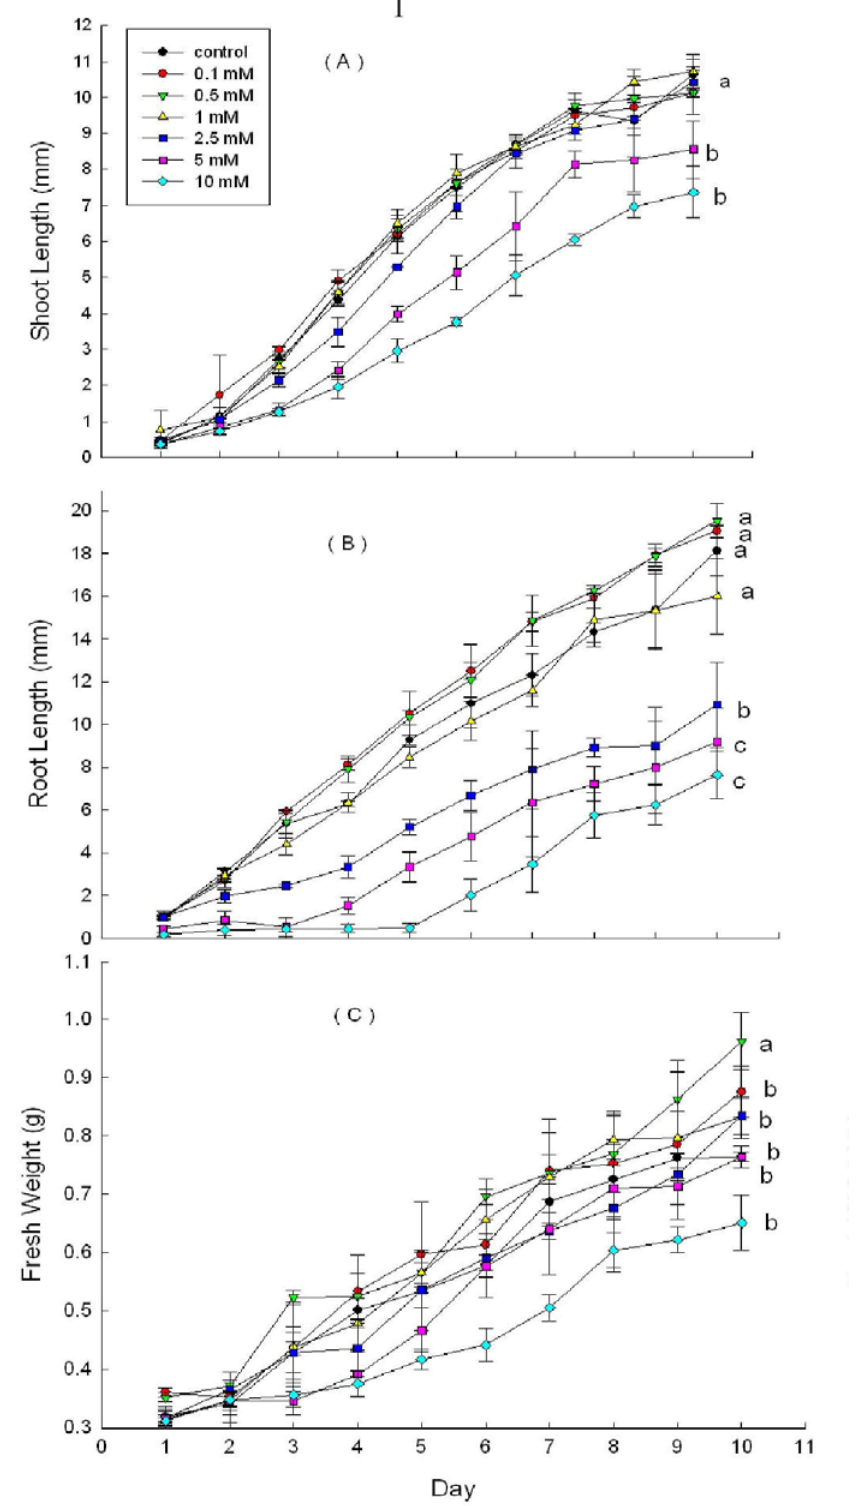
Figure 4. Effects of DHAP on shoot length ( a ), root length ( b ) and fresh weight ( c ) of wheat (I), lettuce (II) and rice (III); Line graphs within the same plot followed by the same letter are not different at P = 0.05 level according to Fisher’s test; Each point is the mean of three replicates ±